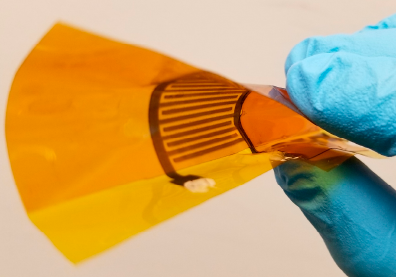
Figure 9. G-CMC filter devices were rolled into a cylinder during mechanical stress tests. There were no measurable differences in frequency response behavior between rolled and unrolled states. As expected, the R and C component values of the individual filters were also unaffected from rolling.